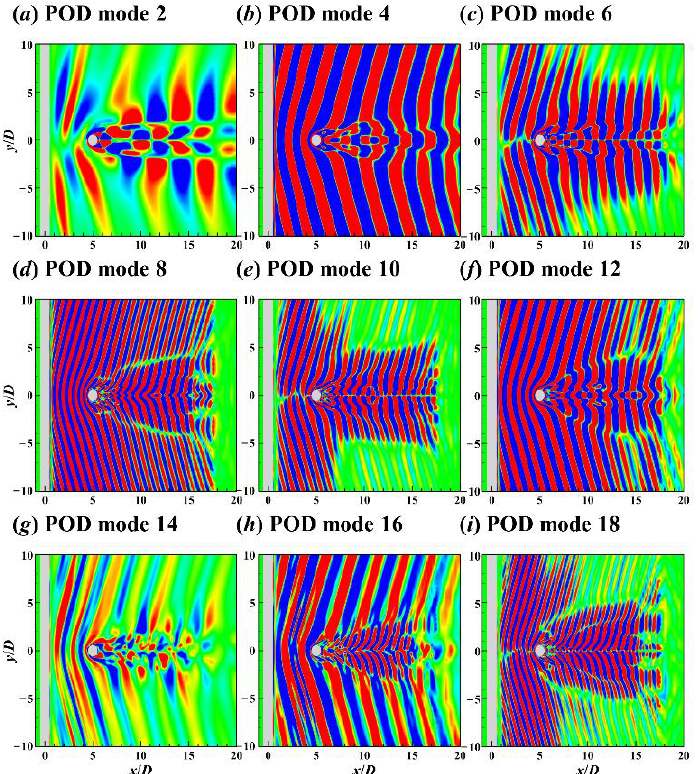
Figure 21. Contours of the 2nd ( a ), 4th ( b ), 6th ( c ), 8th ( d ), 10th ( e ), 12th ( f ), 14th ( g ), 16th ( h ), and 18th ( i ) POD modes on the xy plane for the flow around the two crossing cylinders in 60° arrange- ment.